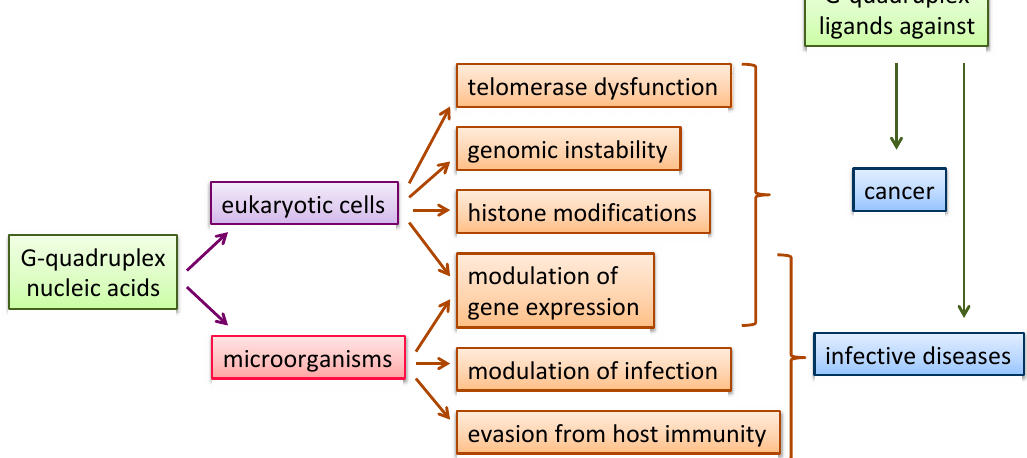
Figure 1. Schematic representation of G4-modulated organisms, biological processes and fields of therapeutic applications.